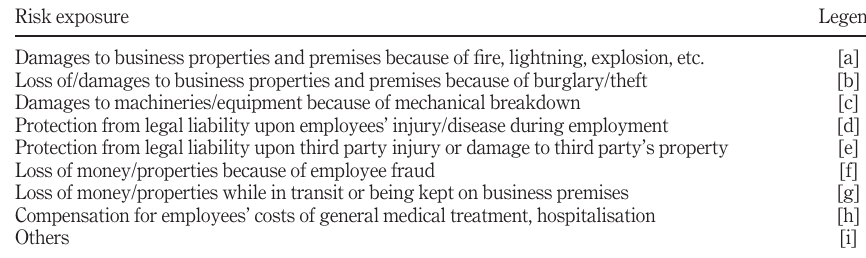
Table I. Risk exposures and its corresponding legend